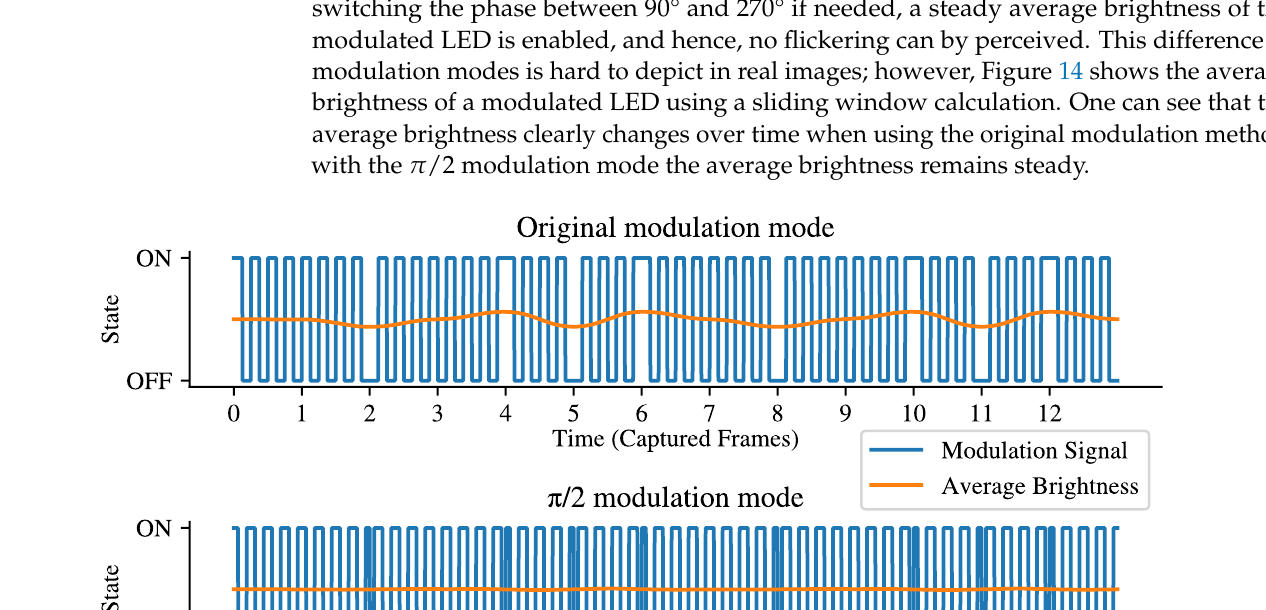
Figure 15. BER depending on pulse width ratio for different exposure settings.